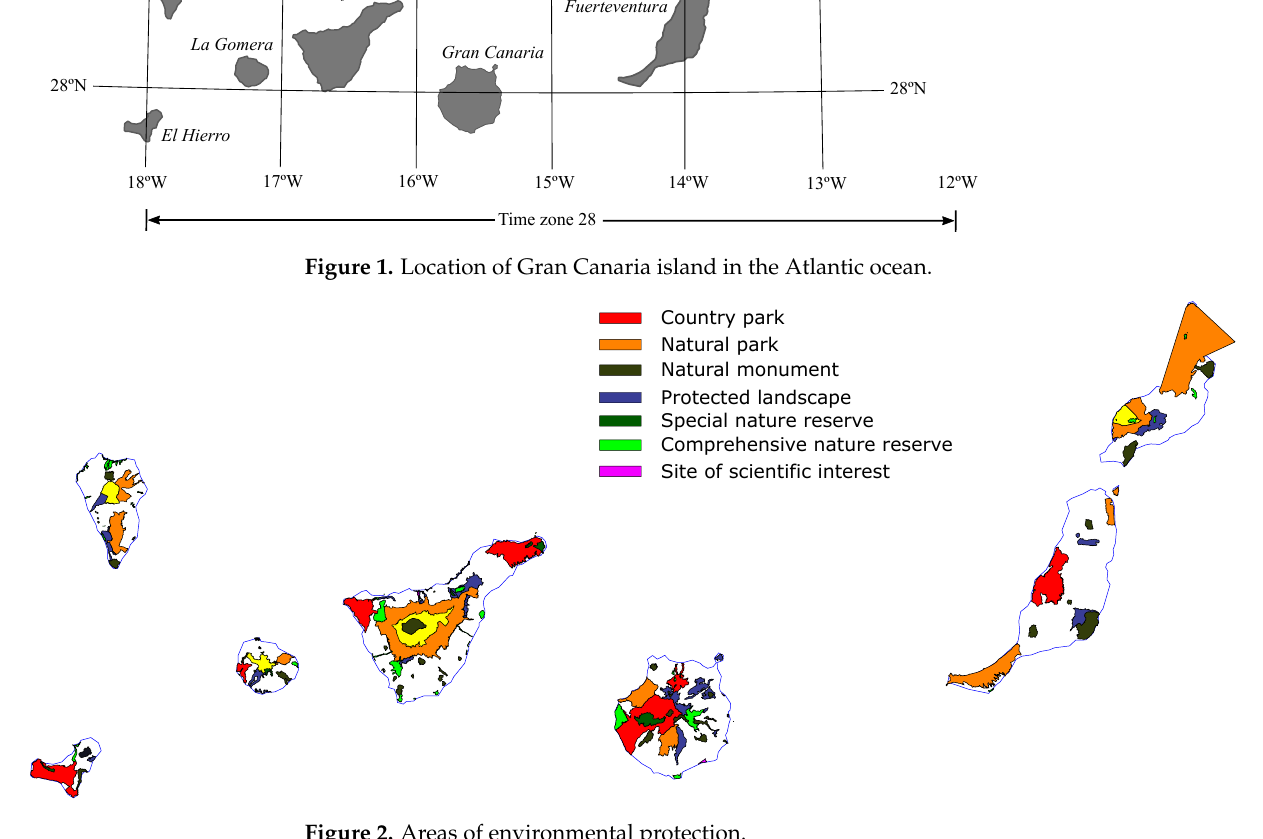
Figure 2. Areas of environmental